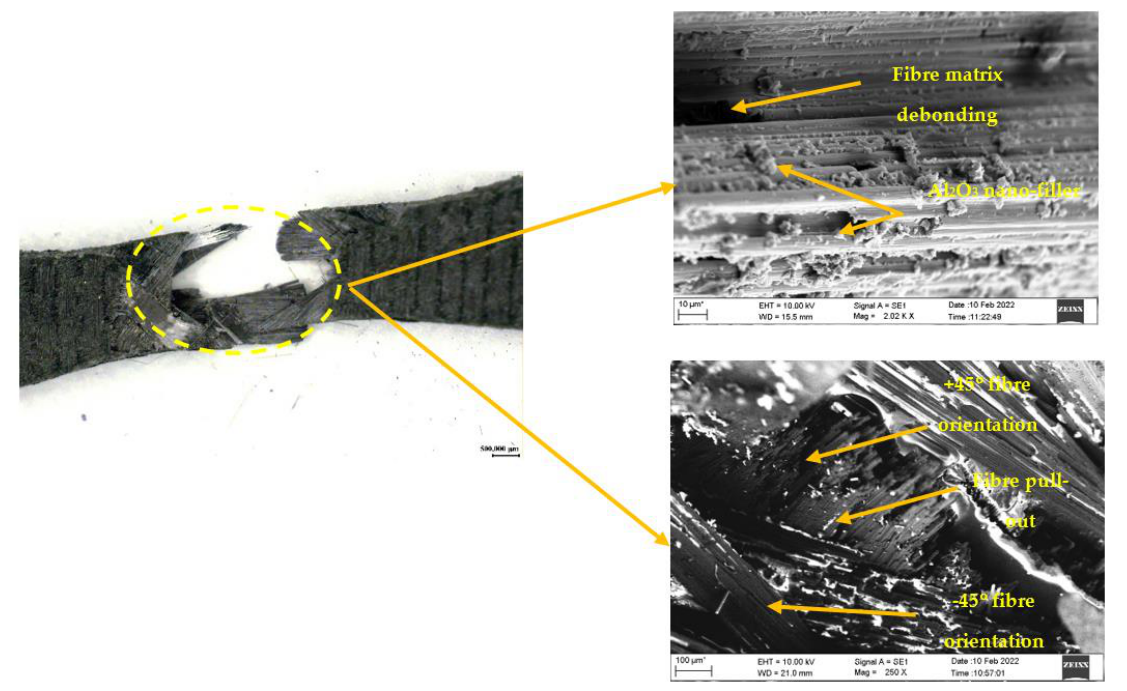
Figure 10. SEM images of tensile failure specimens of hybrid Al 2 O 3 nano-composites at 1.75 wt.%.